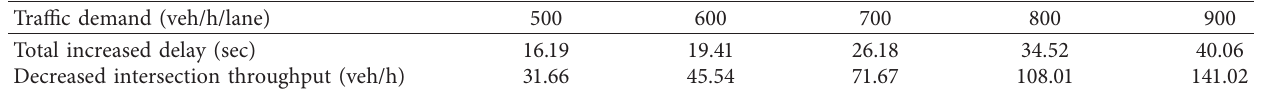
Table 3: Estimated delay increase due to left-turn path